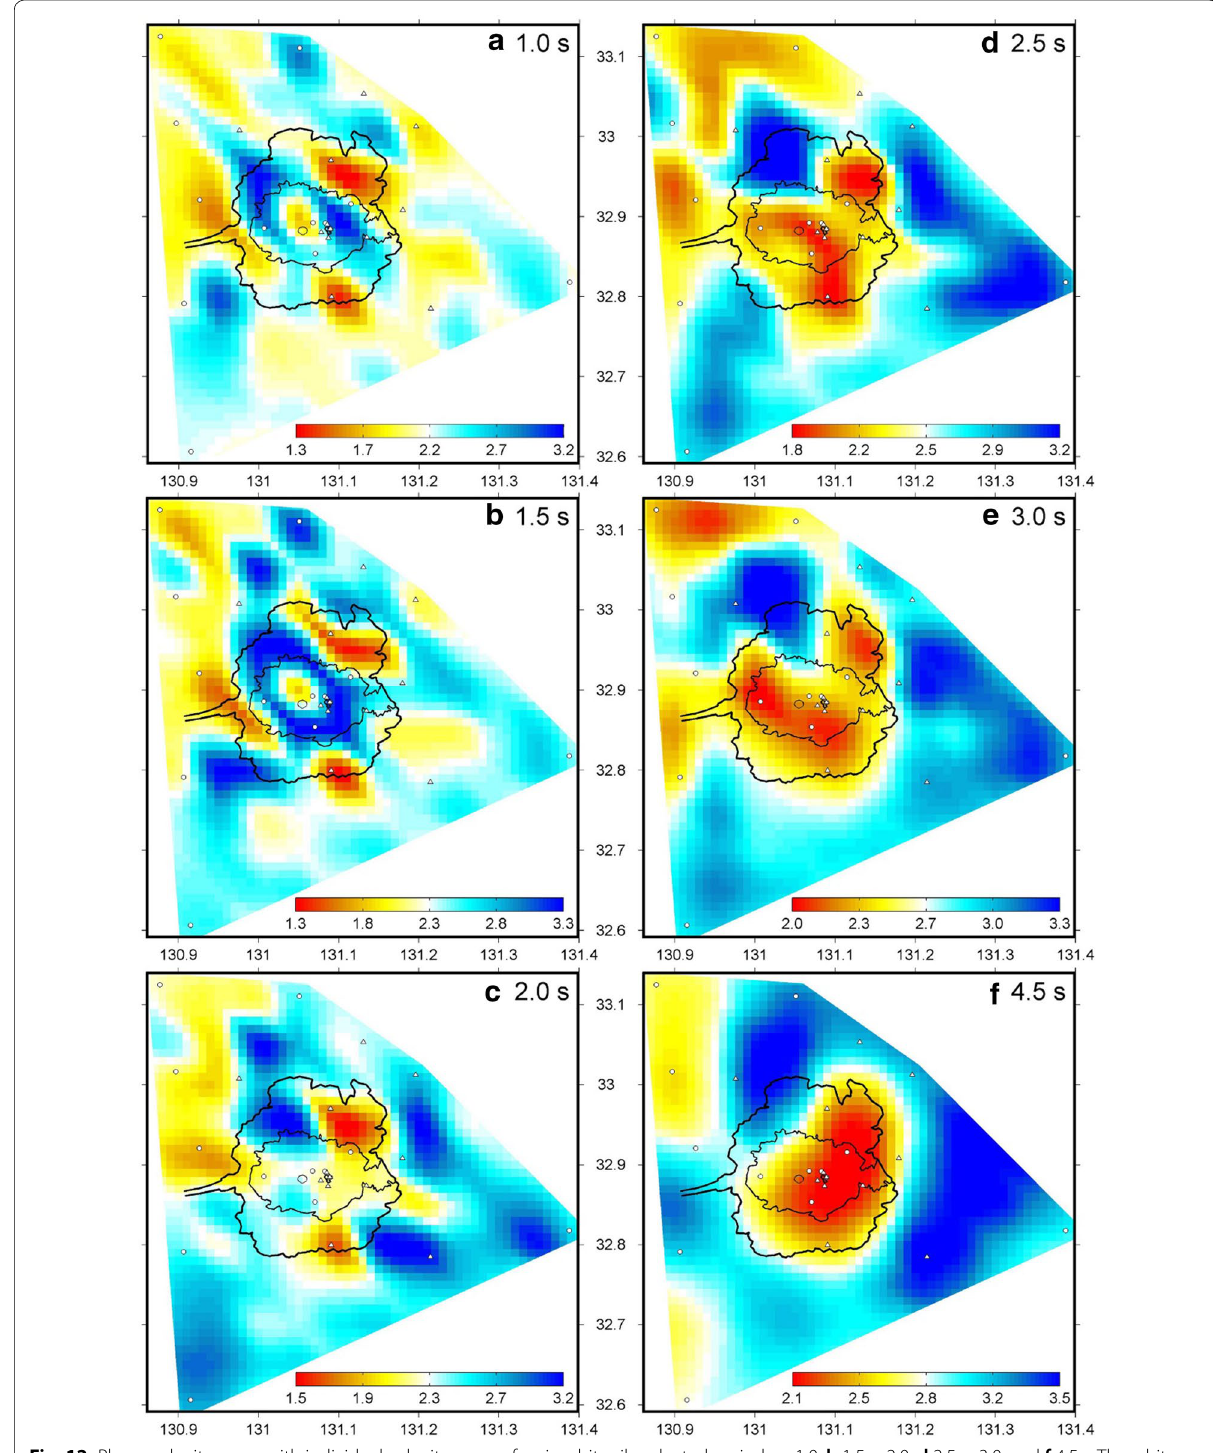
Fig. 12 Phase‑velocity maps with individual velocity ranges for six arbitrarily selected periods: a 1.0, b 1.5, c 2.0, d 2.5, e 3.0, and f 4.5 s. The white circles signify BB stations and white triangles signify SP stations. Large circle at the center of the post‑caldera central cones is Kusasenrigahama as shown in Fig.